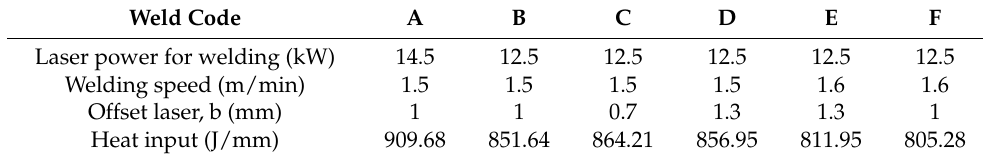
Table 4. Welding variables and parameters of hybrid head for T-joints on single sided. Weld Code A B C D E F Laser power for welding (kW) Welding speed